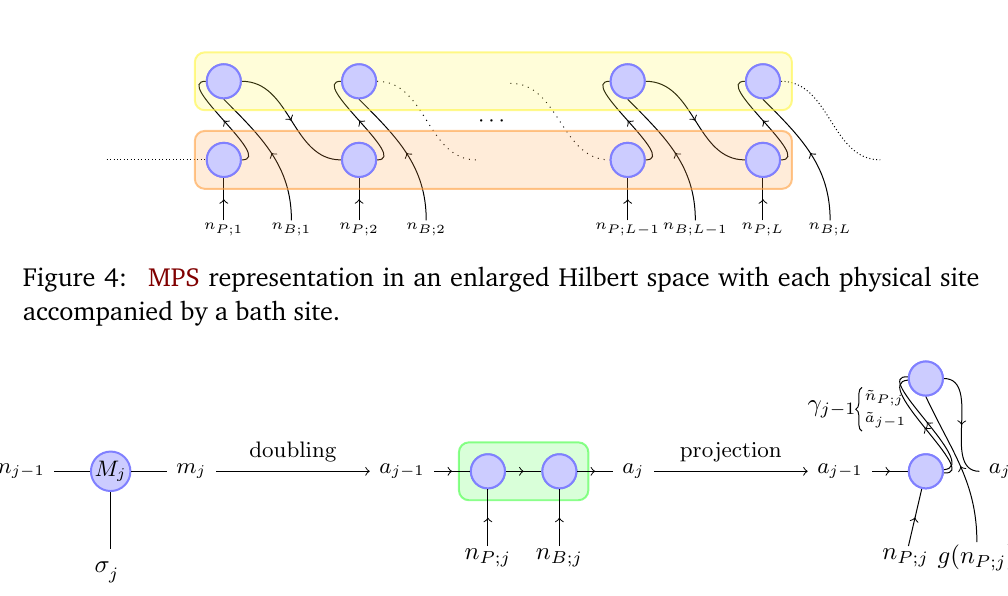
into irreducible representation j − 1 + ˆ n is sketched by double bonds P ; j B ; j